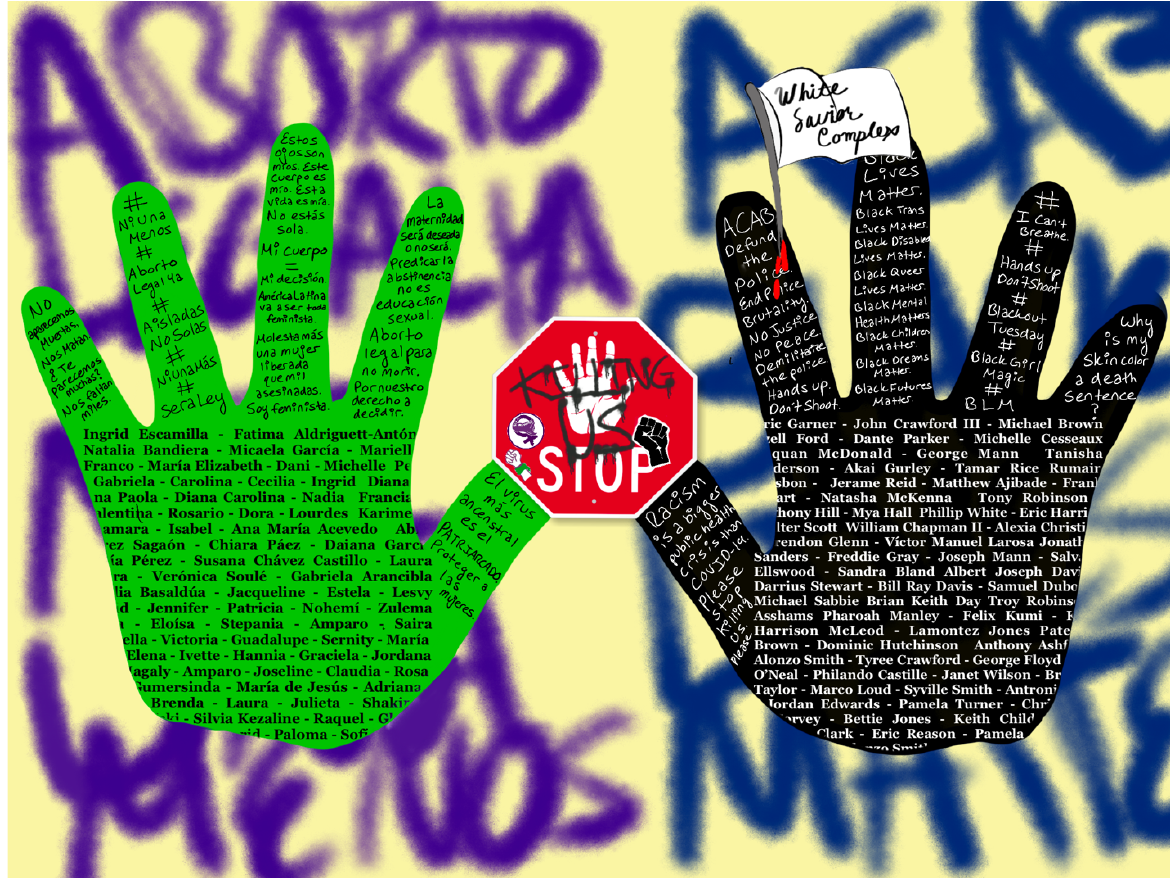
FIG 1.1 “UNTITLED” BY DELANEY GUNSTER FOR LASC 348A “ONLINE AND IN THE STREETS: WOMEN’S STRUGGLES FOR JUSTICE IN LATIN AMERICA.” TRANSLATIONS APPEAR IN THE